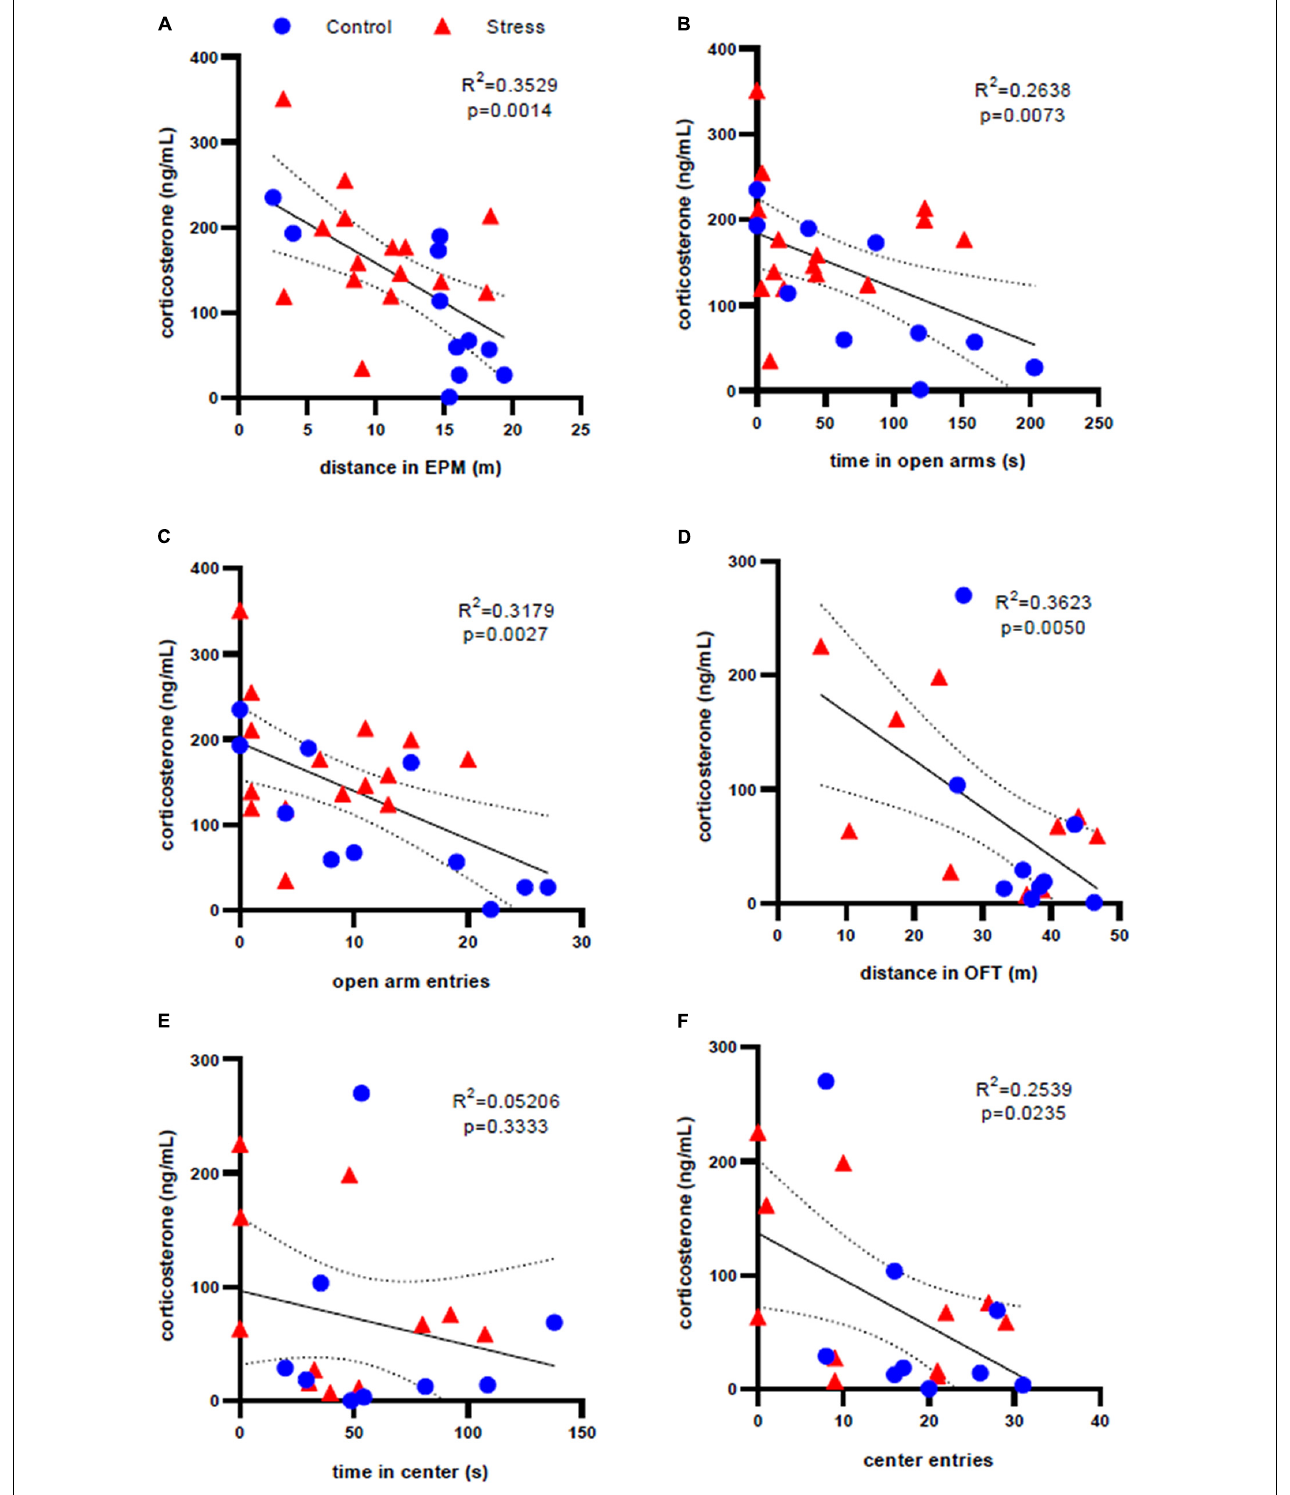
FIGURE 6 | Correlation analysis of corticosterone levels and anxiety-like behavior in adolescent male rats. There is a significant correlation between serum corticosterone concentration 35 min after stress and elevated plus maze behaviors of (A) distance traveled, (B) time in the open arms, and (C) open arm entries. There is a significant correlation between serum corticosterone concentration one week after stress and open field test behaviors of (D) distance traveled and (F) center entries, but not (E) time in the center. Dotted lines represent 95% confidence interval.